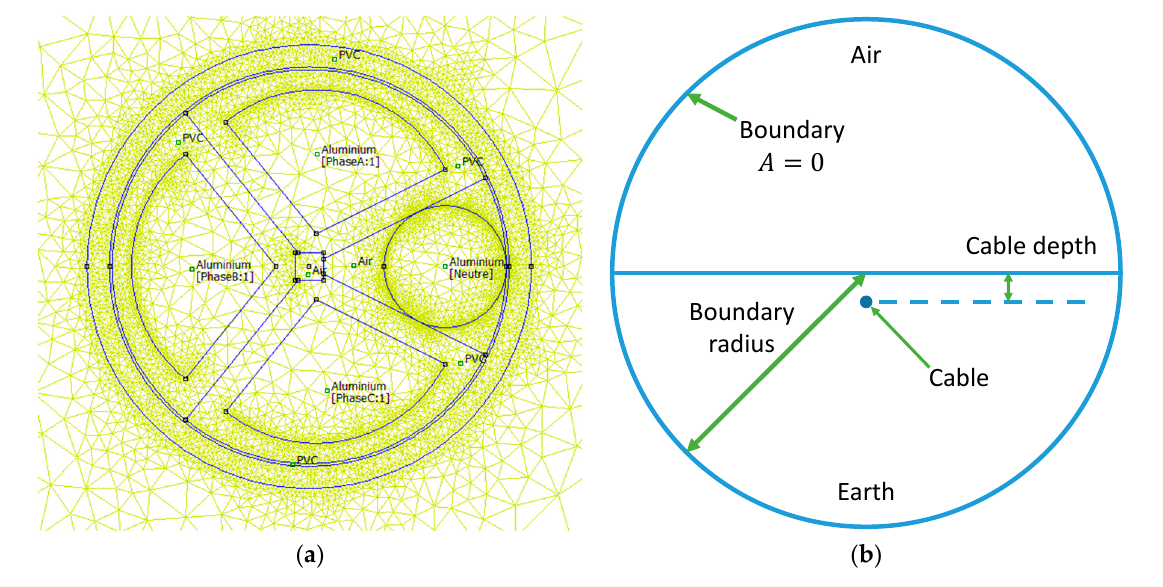
Figure 5. Cable mesh ( a ) and general view ( b ) for the FEM.